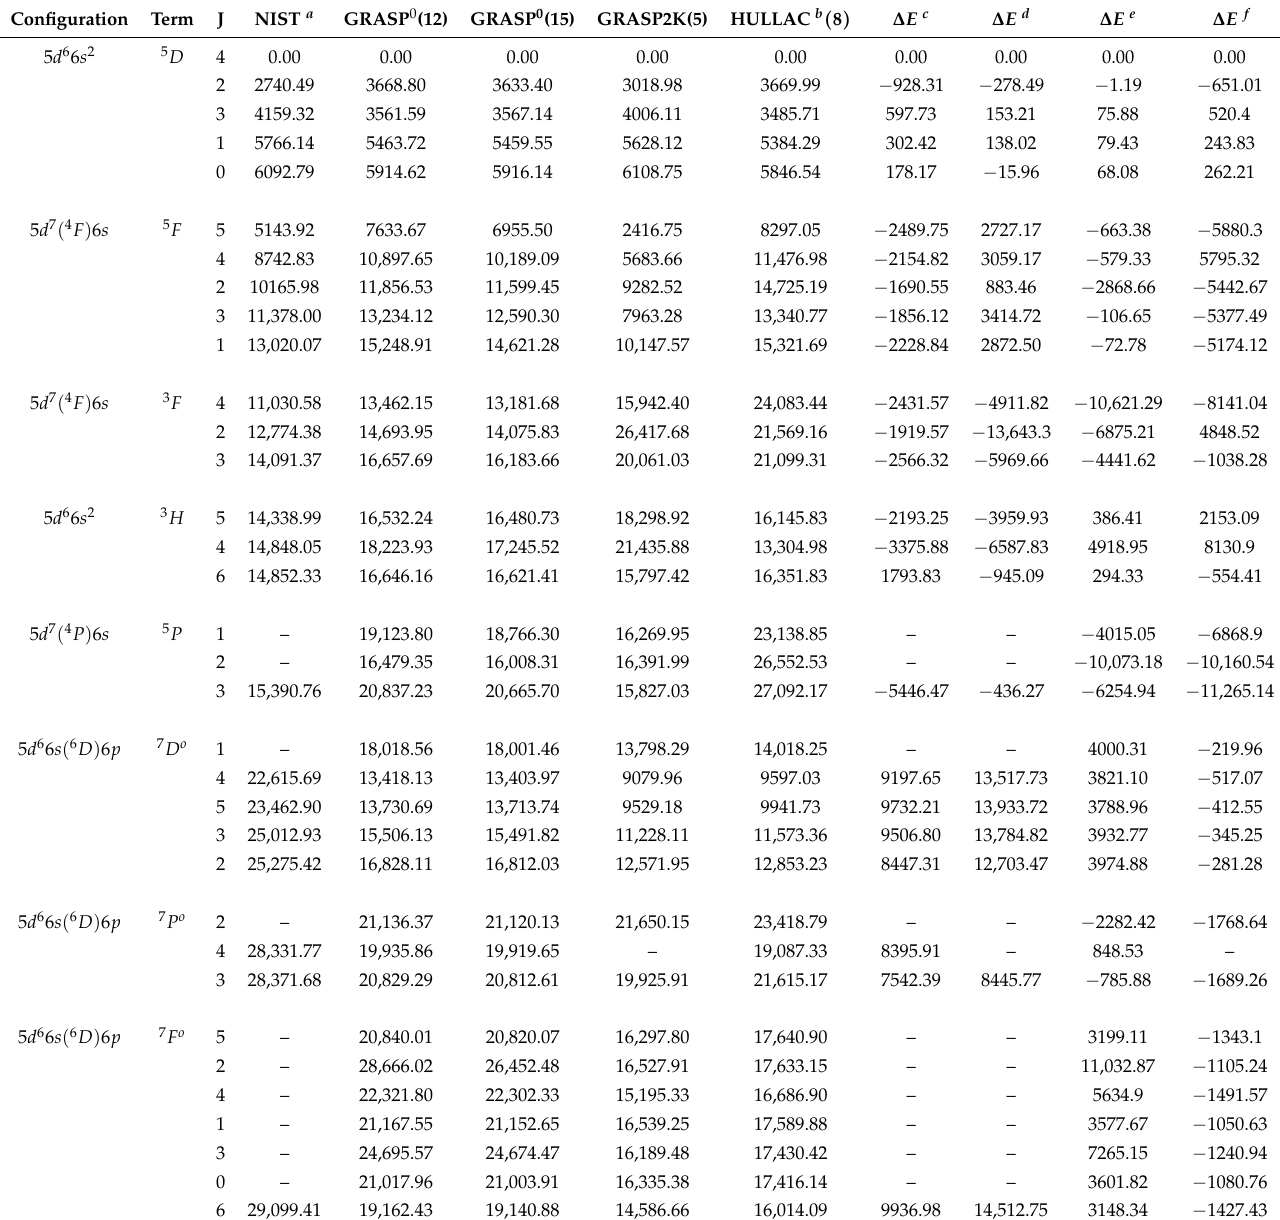
Table 2. Energy levels in cm − 1 for Os I. The GRASP 0 , GRASP2K, and HULLAC calculations have been performed with configuration numbers given in